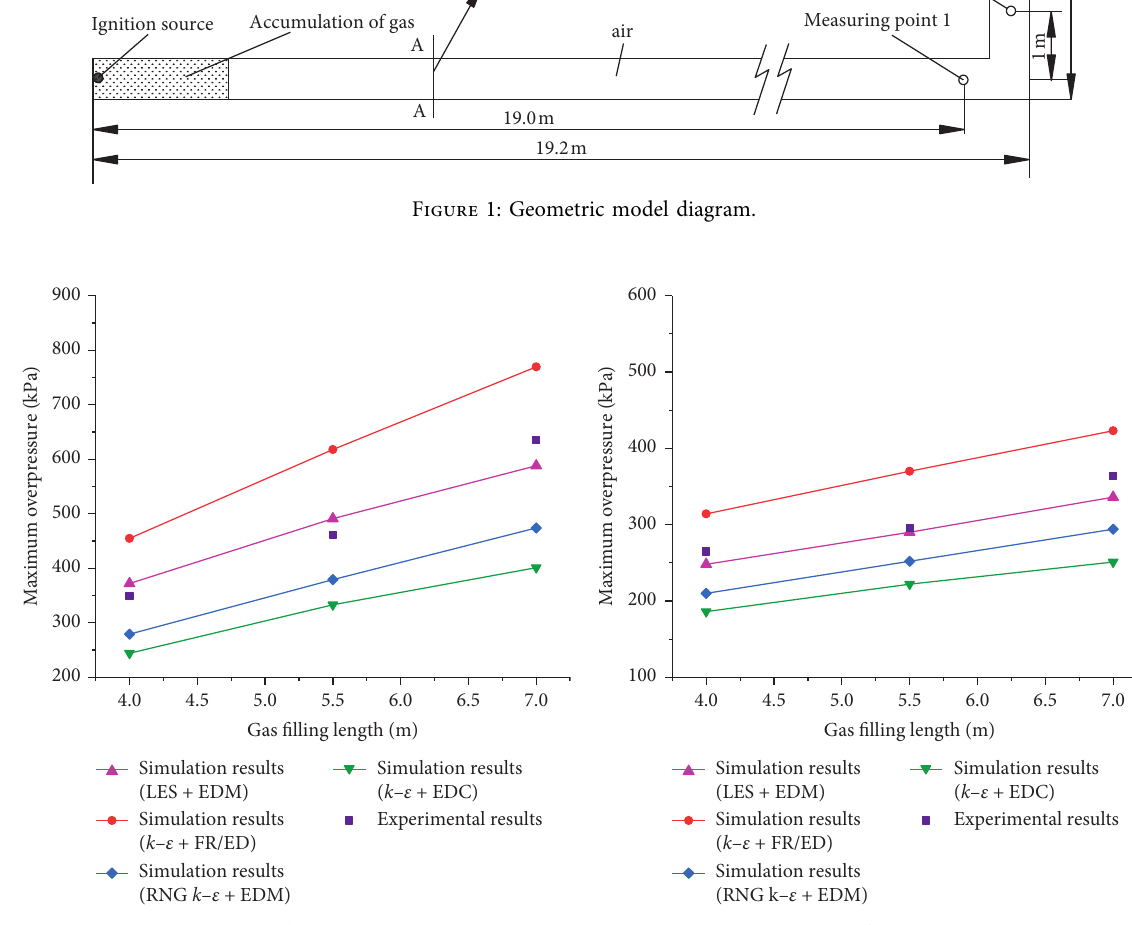
Figure 2: Comparison between simulation results and experimental results. (a) Comparison of results at measuring point 1. (b) Comparison of results at measuring point 2.